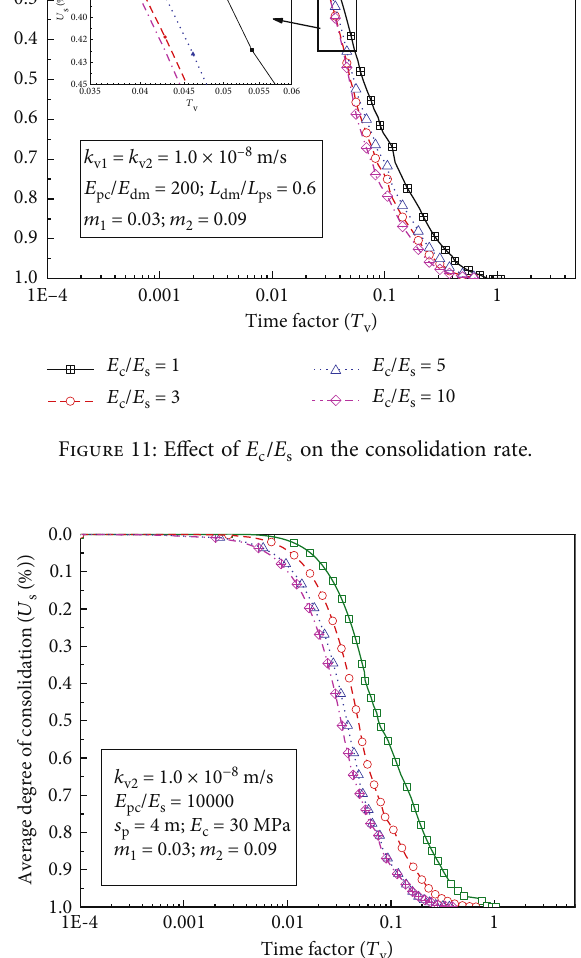
/ k on the consolidation rate. v1 v2